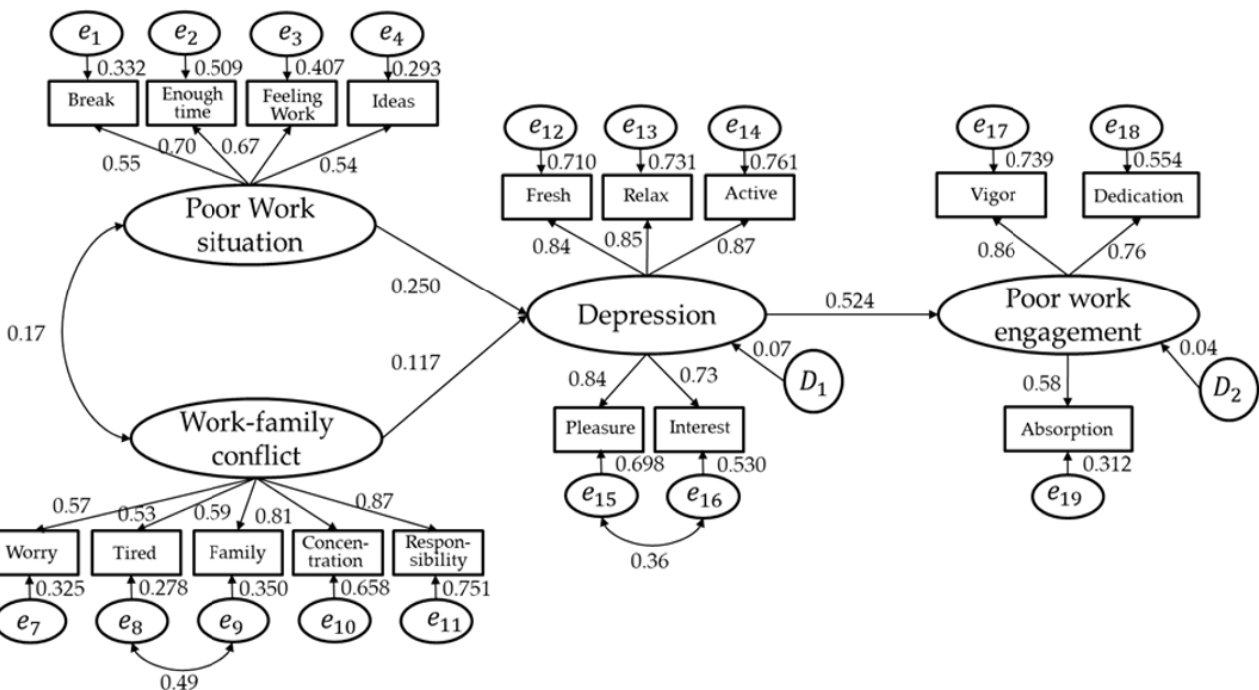
Figure 2. Final model of this study. Rectangle, measurement variable; ellipse, latent variable; Di, disturbance or residual; ei, measurement error.